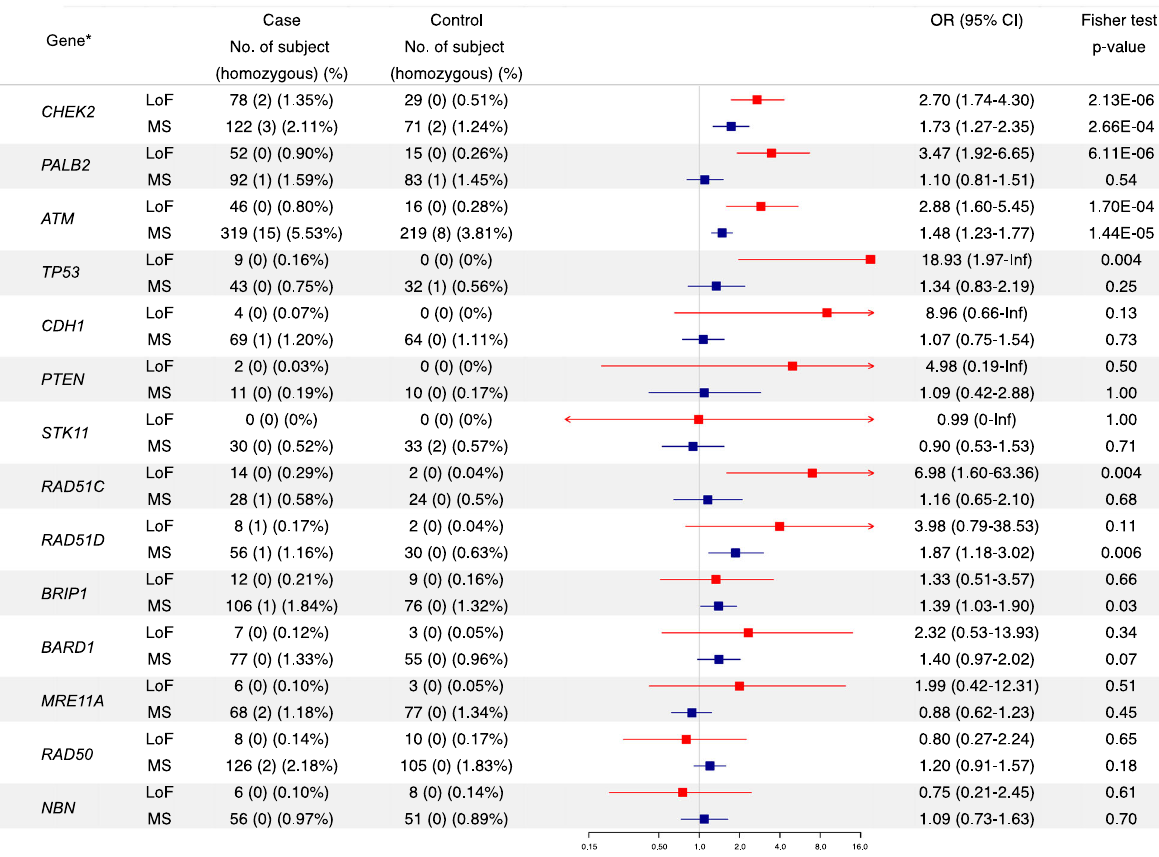
Fig. 2 Case-control frequencies of rare LoF (MAF < 0.005) and MS (MAF < 0.001) variants in known or proposed HBOC genes ( N = 14). *Part of the data have been published previously in J. Clin. Oncol . 34(13), 1455 – 1459, Genet. Med . 21(4), 913 – 922, J. Pathol. 245(1), 53 – 60, J. Natl Cancer Inst . 111(12), 1332 – 1338, Nat. Genet . 50(10), 1346 – 1348 and Breast Cancer Res. Treat . 159(2), 385 – 392. Known pathogenic MS variants in ATM (c.7271 T > G) and TP53 (c.524 G > A, c.712 T > C, c.725 G > A, c.733 G > A, c.742 C > T and c.1009 C > T) were classi fi ed as LoF variants in this